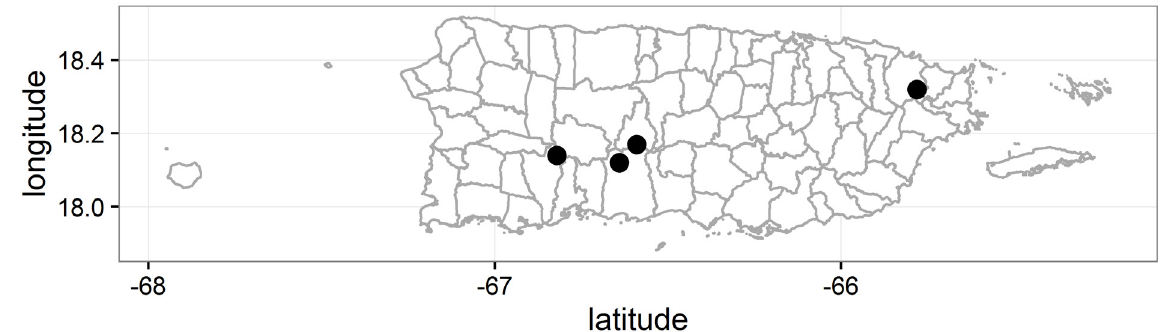
Fig. 26. Distribution map for Lasioglossum eickwortellum (Engel,